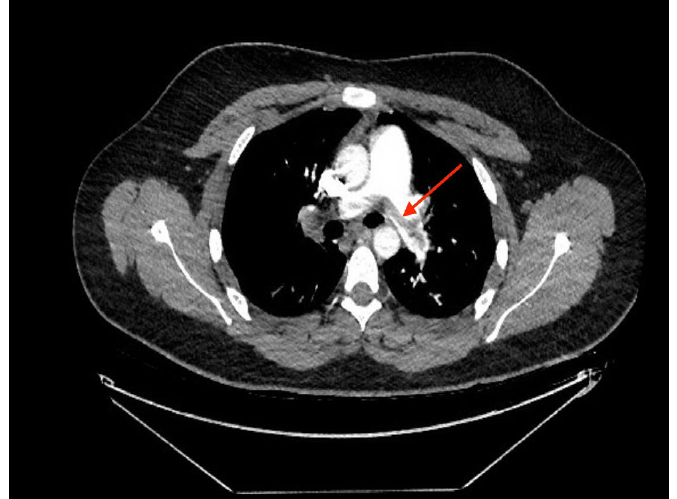
Image 3. Axial view of the chest on computed tomography for pulmonary angiogram, demonstrating a saddle pulmonary embolism (arrow), with near-occlusive clot in the right pulmonary